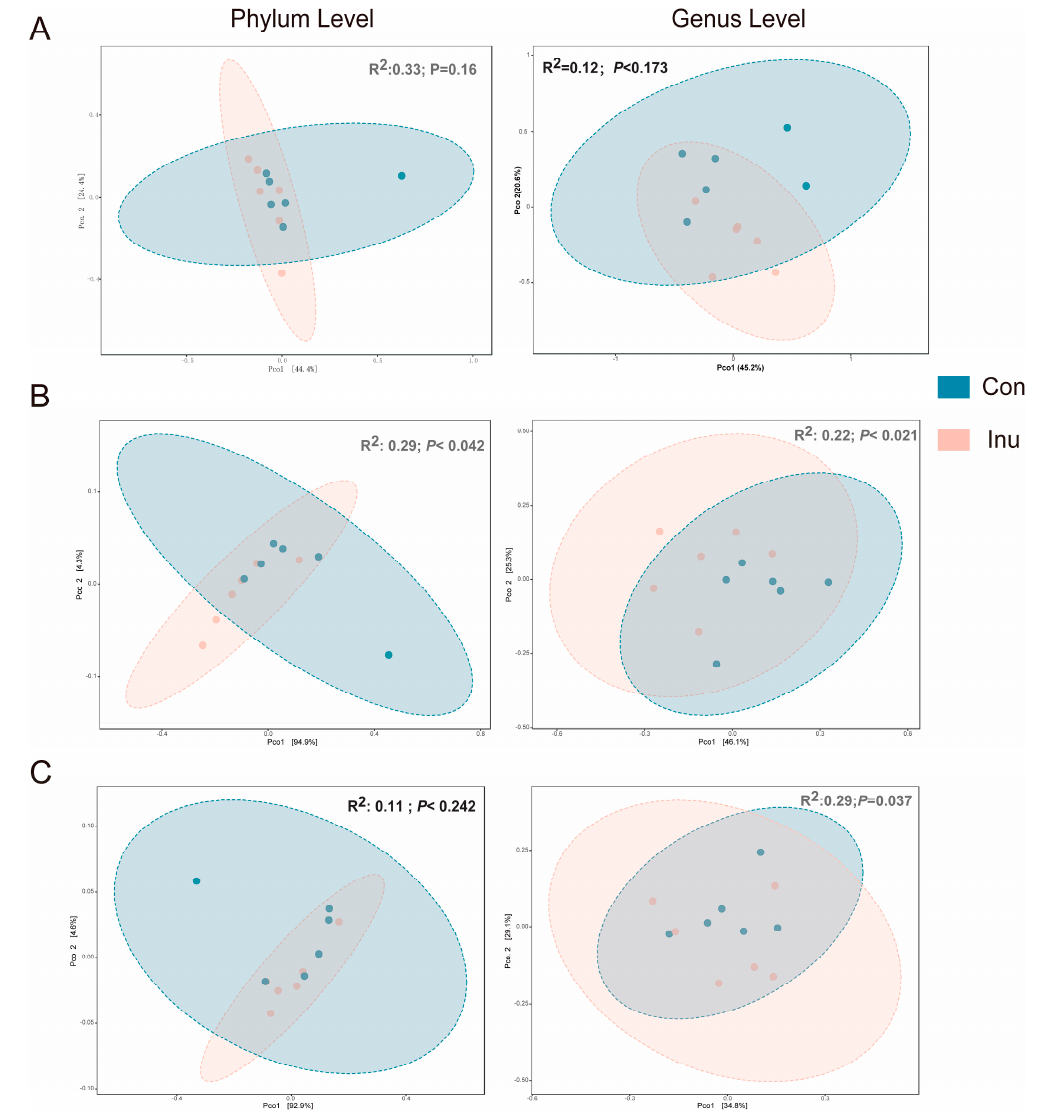
Figure 2. E ff ect of inulin on bacterial community across luminal regions in growing pigs fed a diet with or without a 5% inulin supplement. Distances created with Bray-Curtis show phylum or genus level in di ff erent luminal regions, Ileum ( A ), Cecum ( B ), Colon ( C ). p value represents diet di ff erences among PCoA scores along component 1. Con, control; Inu,